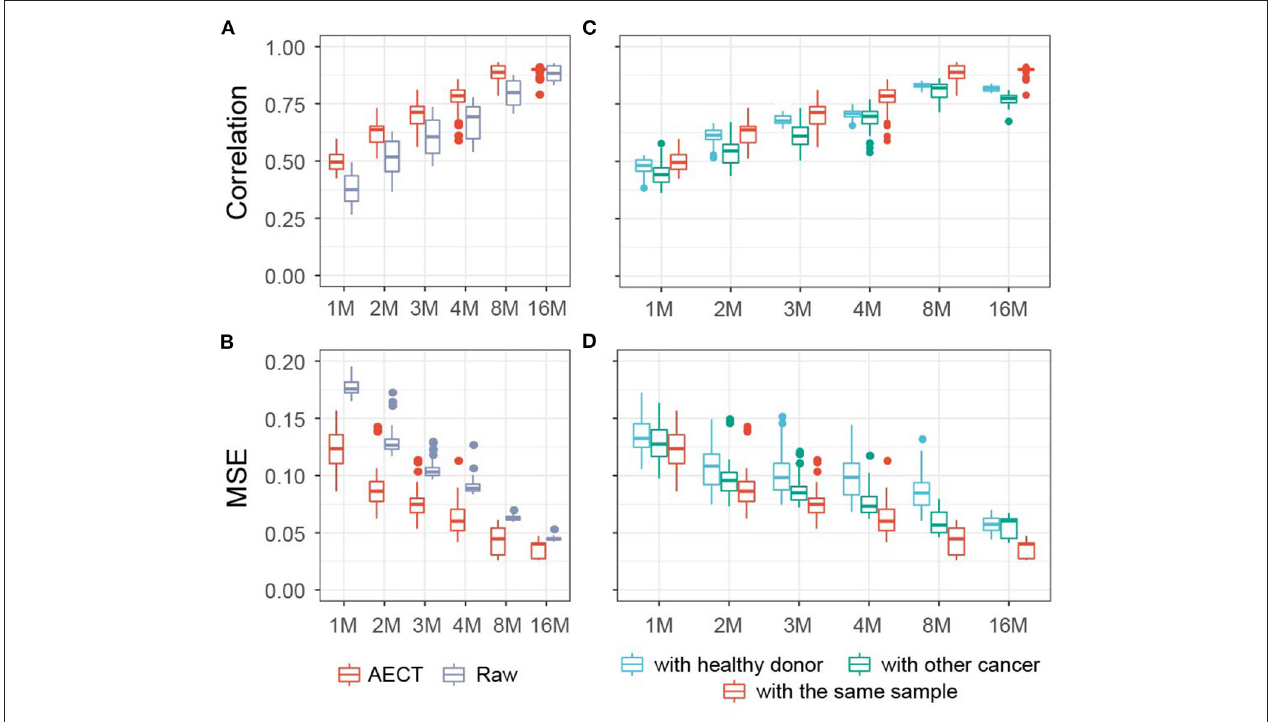
FIGURE 2 | AECT improved accuracy of TSS coverage profiles in simulated data of cancer patients. (A,B) AECT increased the Pearson correlation coefficient (A) and decreased the MSE (B) for shallow data and original high depth data. (C,D) AECT generated a higher Pearson correlation coefficient (C) and a lower MSE (D) with the original high-depth data than with the high-depth data of other cancer samples and healthy donors. The x-axis represents the read counts for the simulated shallow-sequencing data. The box represents the interquartile range, the horizontal line in the box is the median, and the whiskers represent 1.5 times the interquartile